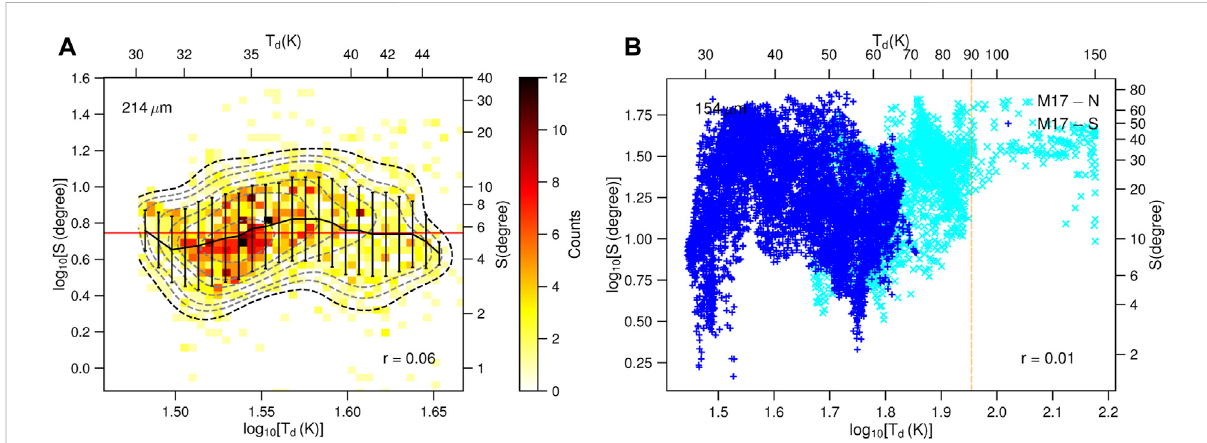
FIGURE 13 (A) 2D-histogram of S and T d in 30 Dor at 214 μ m ( fi gure adopted from Tram et al. in prep.). They have a loose relation with a correlation coef fi cient of r = 0.06. Thus, the variation of magnetic fi eld could not be a main reason for a decrease in p with T d > 43 K, as shown in Figure 10. (B) Scatter plot of S vs. T d for M17 at 154 μ m ( fi gure adopted from Hoang T. D. et al., 2022) with a correlation coef fi cient of r = 0.01. In particular, S is weakly correlated with T d > 90 K (dashed vertical line) in M17-N and could not explain the drop of p for such high T d , as shown in Figure